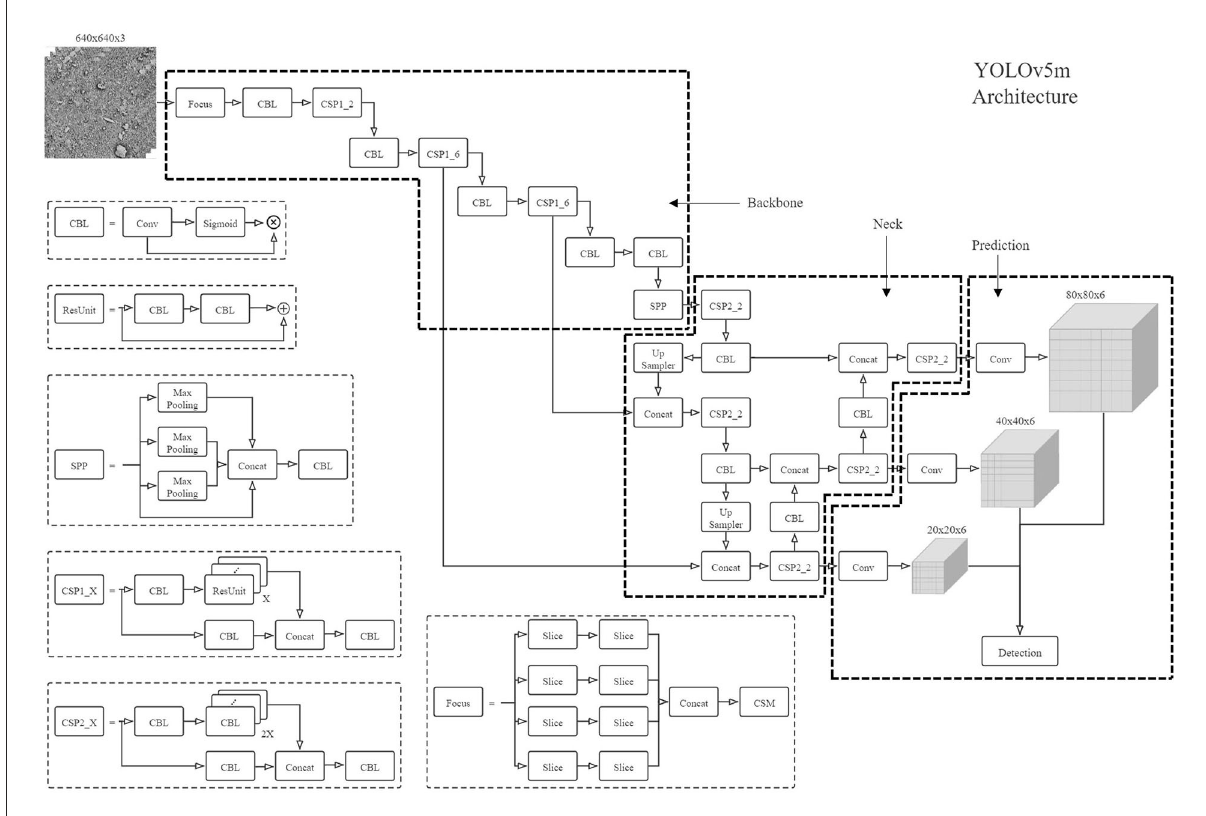
FIGURE4 The YOLOv5m